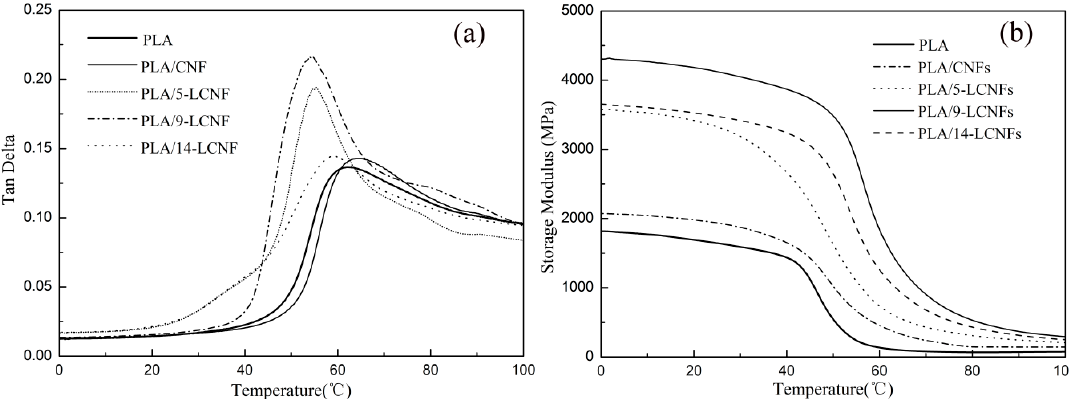
Figure 7. ( a ) Storage modulus and ( b ) tan Δ versus temperature for PLA and the PLA/LCNFs ( a ) Storage modulus and ( b ) tan ∆ versus temperature for PLA and the composites. PLA/LCNFs